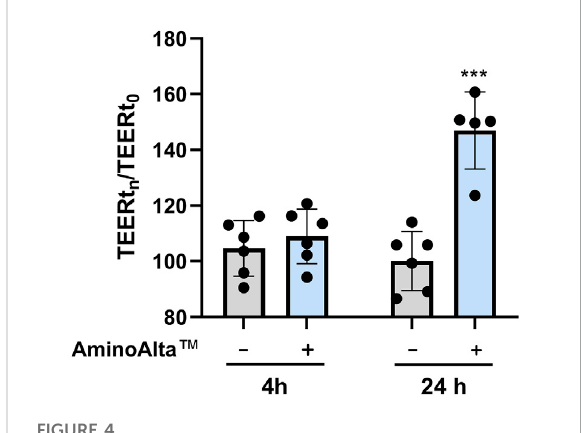
Transepithelial electrical resistance (TEER) measurements of Caco-2 cell layers exposed to the AminoAlta ™ probiotic formulation (+) or unstimulated ( − ) after 4 and 24 h. Data are means of results from six independent experiments ± standard deviations. Asterisks indicate statistically signi fi cant differences according to a two-tailed unpaired Student ’ s t-test. ***, p <